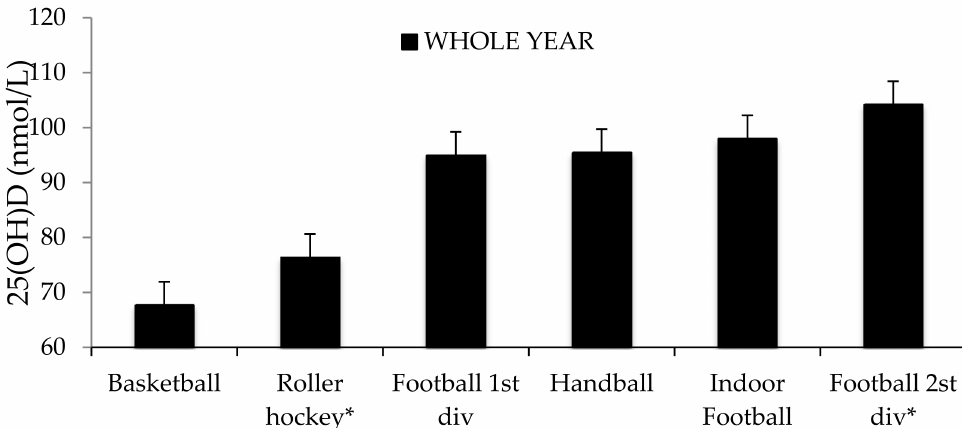
Figure 1. Mean 25(OH)D concentrations of the whole year according to sport modality as mean ± standard error. * Football 2nd division, indoor football, and roller hockey (indoor) were fully supplemented during the whole